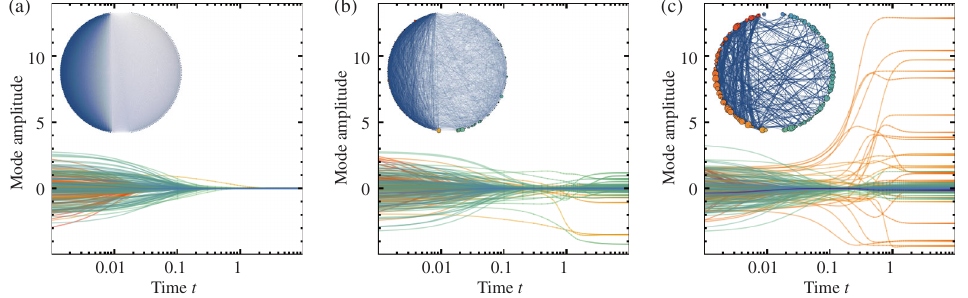
FIG. 3. Generic suppression of pattern formation with a designed discrete band gap. (a) Pattern formation in the Swift-Hohenberg system is completely suppressed by constructing a gap around the range of unstable eigenvalues [Fig. 1(c)]. (b) On a sparsified graph that has a few eigenvalues just within the unstable region, some modes settle at small nonzero values. (c) On the random graph many more eigenvalues are well within the unstable region and the corresponding modes settle at larger amplitudes. The inset graphs show the final steady state on each graph. All simulations used identical initial conditions u D 2 ¼ 1 . See Video 2 in Supplemental Material [56] for